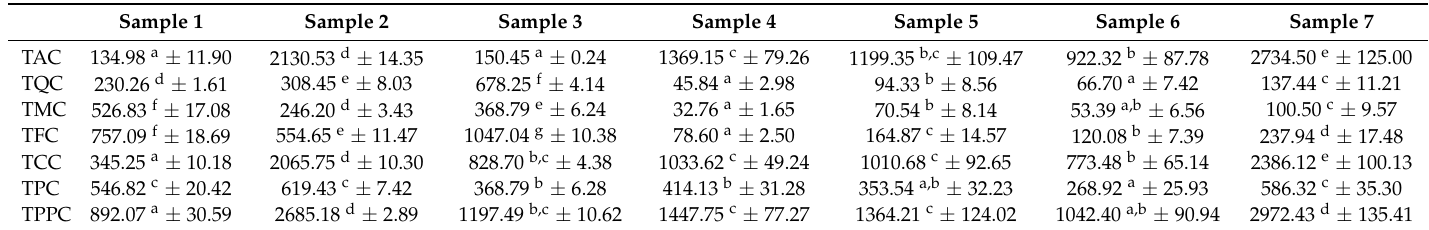
Table 3. Total anthocyanin content (TAC), total quercetin derivatives content (TQC), total myricetin derivatives content (TMC), total flavonol content (TFC), total catechol derivatives content (TCC), total pyrogallol derivatives content (TPC) and total polyphenol content (TPPC) results expressed as µ mol/100 g dry